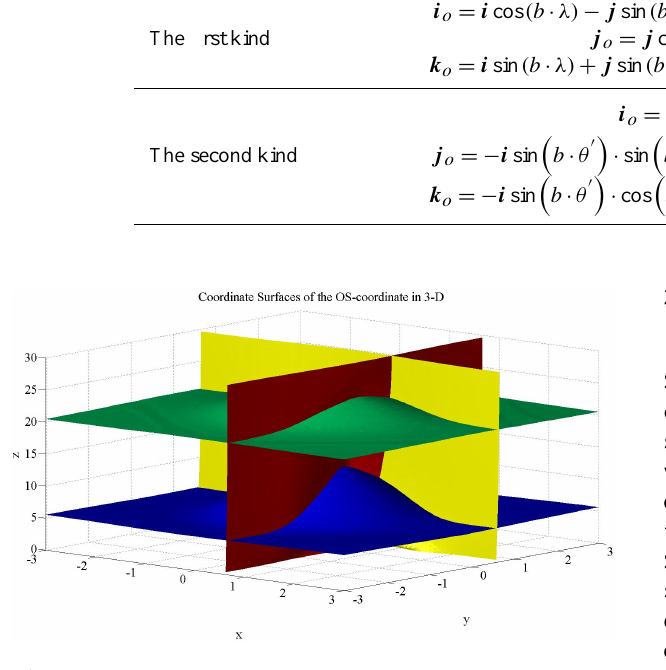
Figure 4. Coordinate surfaces of the OS coordinate in 3-D. The red and yellow surfaces are x 0 and y 0 coordinate surfaces; the blue and green surfaces represent the σ coordinate surfaces at two different heights.